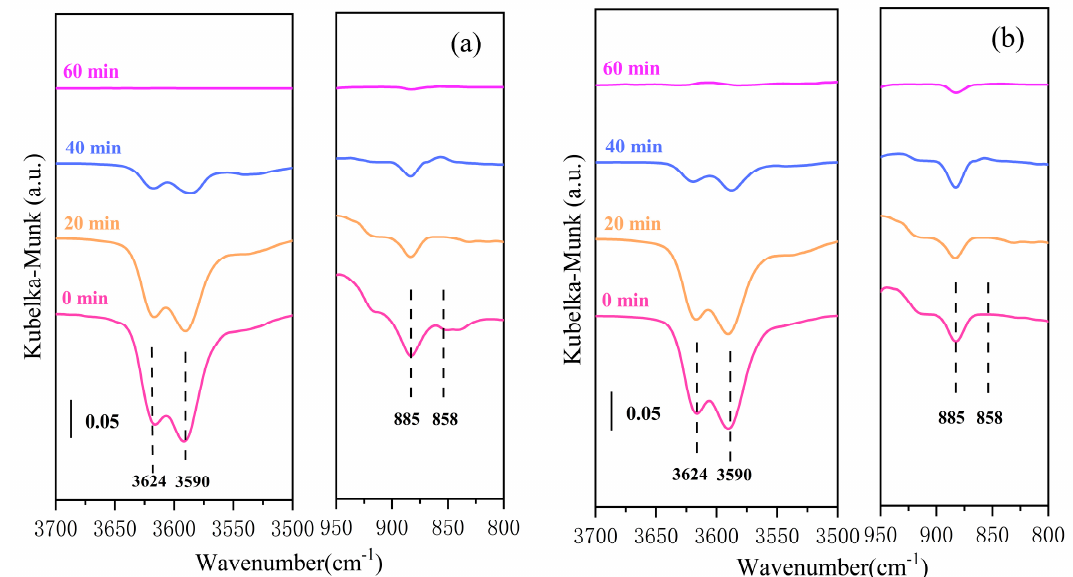
Figure 11. The DRIFTS spectra of saturated NH 3 titration by ( a ) NO + O 2 , and ( b ) NO + C 3 H 6 + O 2 over Cu-SAPO-34 at 200 °C.